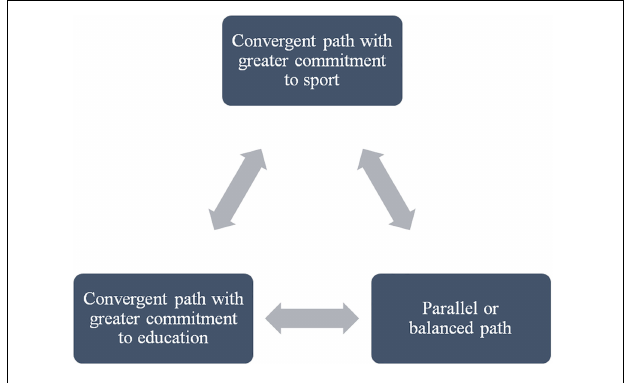
FIGURE 1 | Types and fluidity of transition